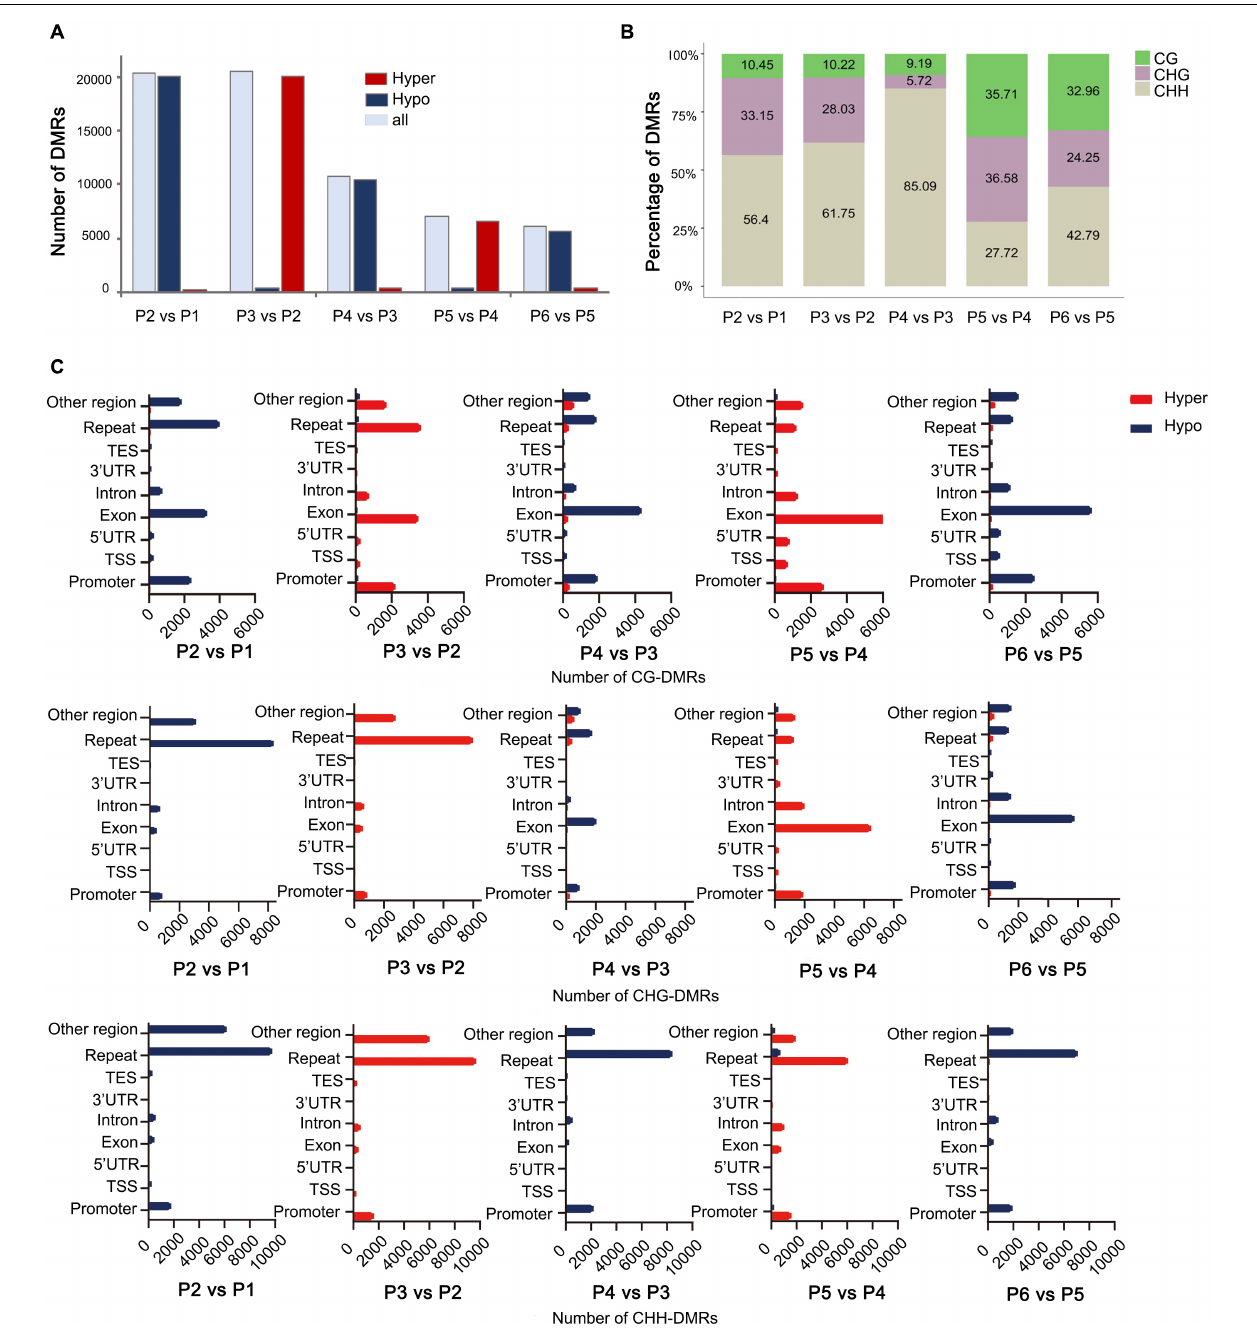
FIGURE 4 | Distribution of DMRs among different stages of tissue culture of F. nilgerrensis . (A) The number of DMRs in each comparation between adjacent stages. (B) Proportion of three contexts (CG, CHG, CHH) in DMRs between each adjacent stage. (C) Number of CG/CHG/CHH-DMRs distributed in different genomic